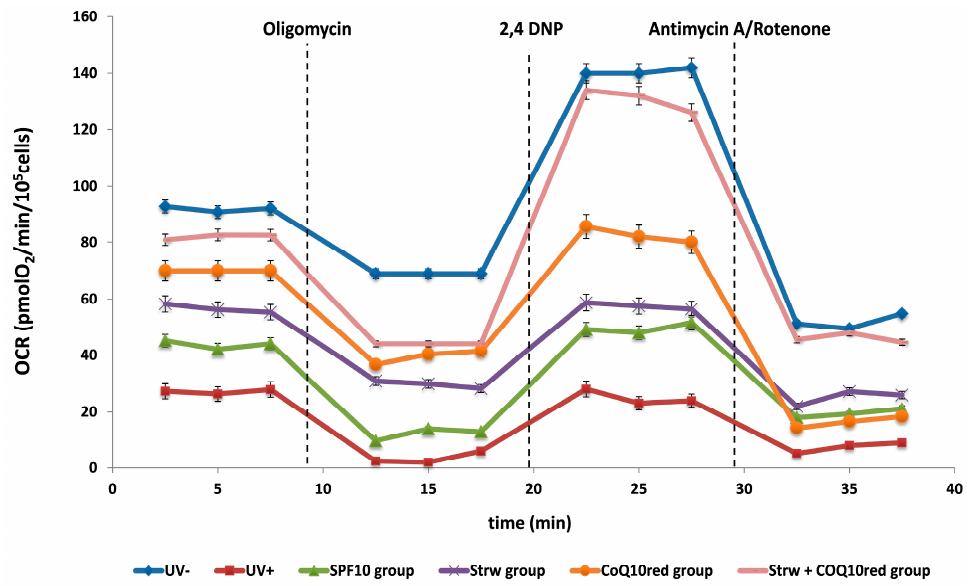
Figure 4. Oxygen consumption rate (OCR) value of human dermal fibroblast (HDF) cells irradiated with ultraviolet A (UVA, 275 kJ/m 2 ) radiation (UV+) or not irradiated (UV − ), after 1 h of exposure. HDF were screened with different formulations as explained in the text. Data are expressed as mean values ± standard deviation (SD).